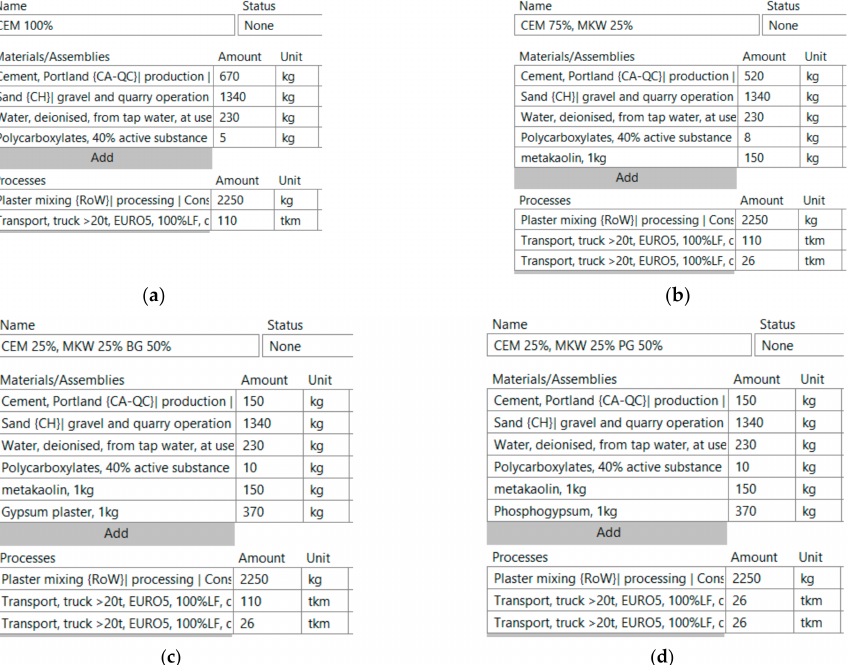
Figure 3. Input data in SimaPro software for 1 m 3 of mortar (2250 kg/m 3 ). ( a ) Cement mortar with 100% CEM; ( b ) cement mortar with MKW; ( c ) GCP mortar with commercial gypsum; ( d ) GCP mortar with